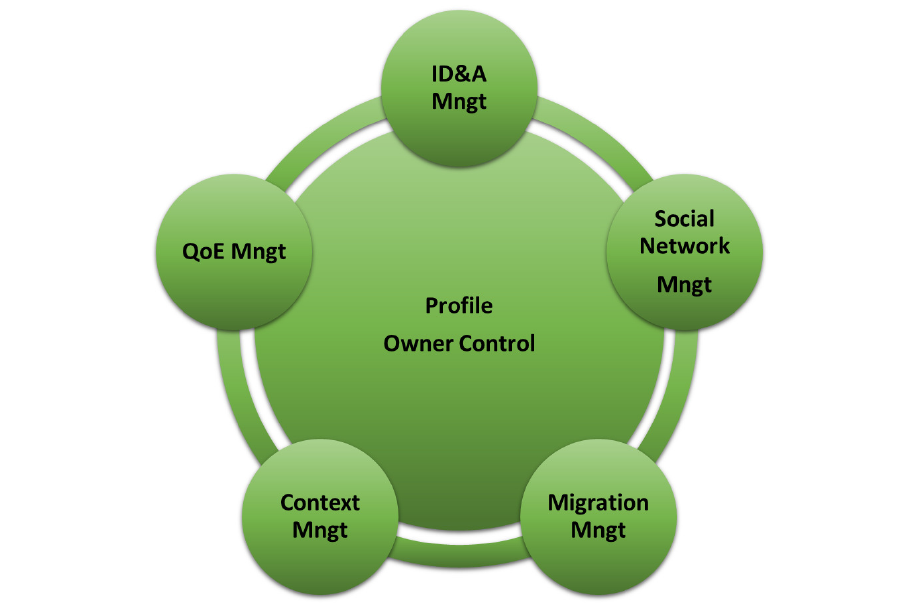
Figure 4. Main components of the VU